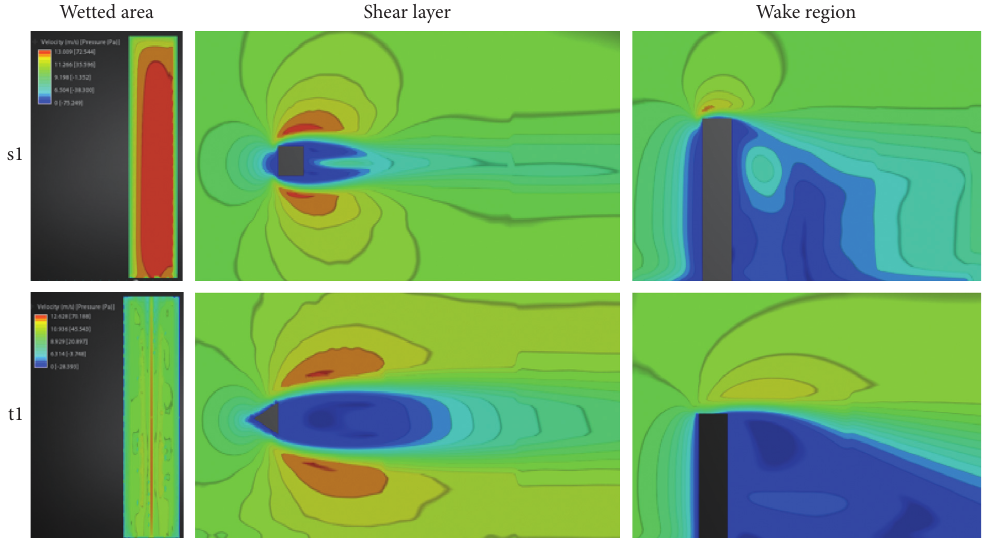
Figure 5: Examining the three behaviors of wind against tall buildings on the based